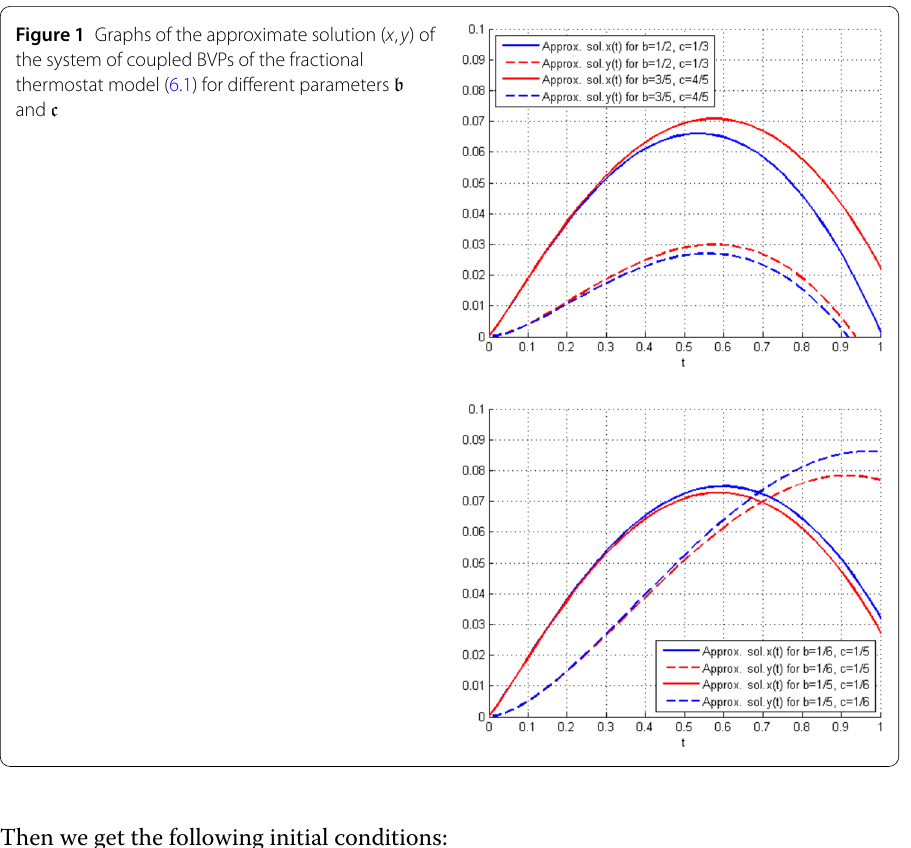
Figure 1 Graphs of the approximate solution ( x , y ) of the system of coupled BVPs of the fractional thermostat model (6.1) for different parameters b and